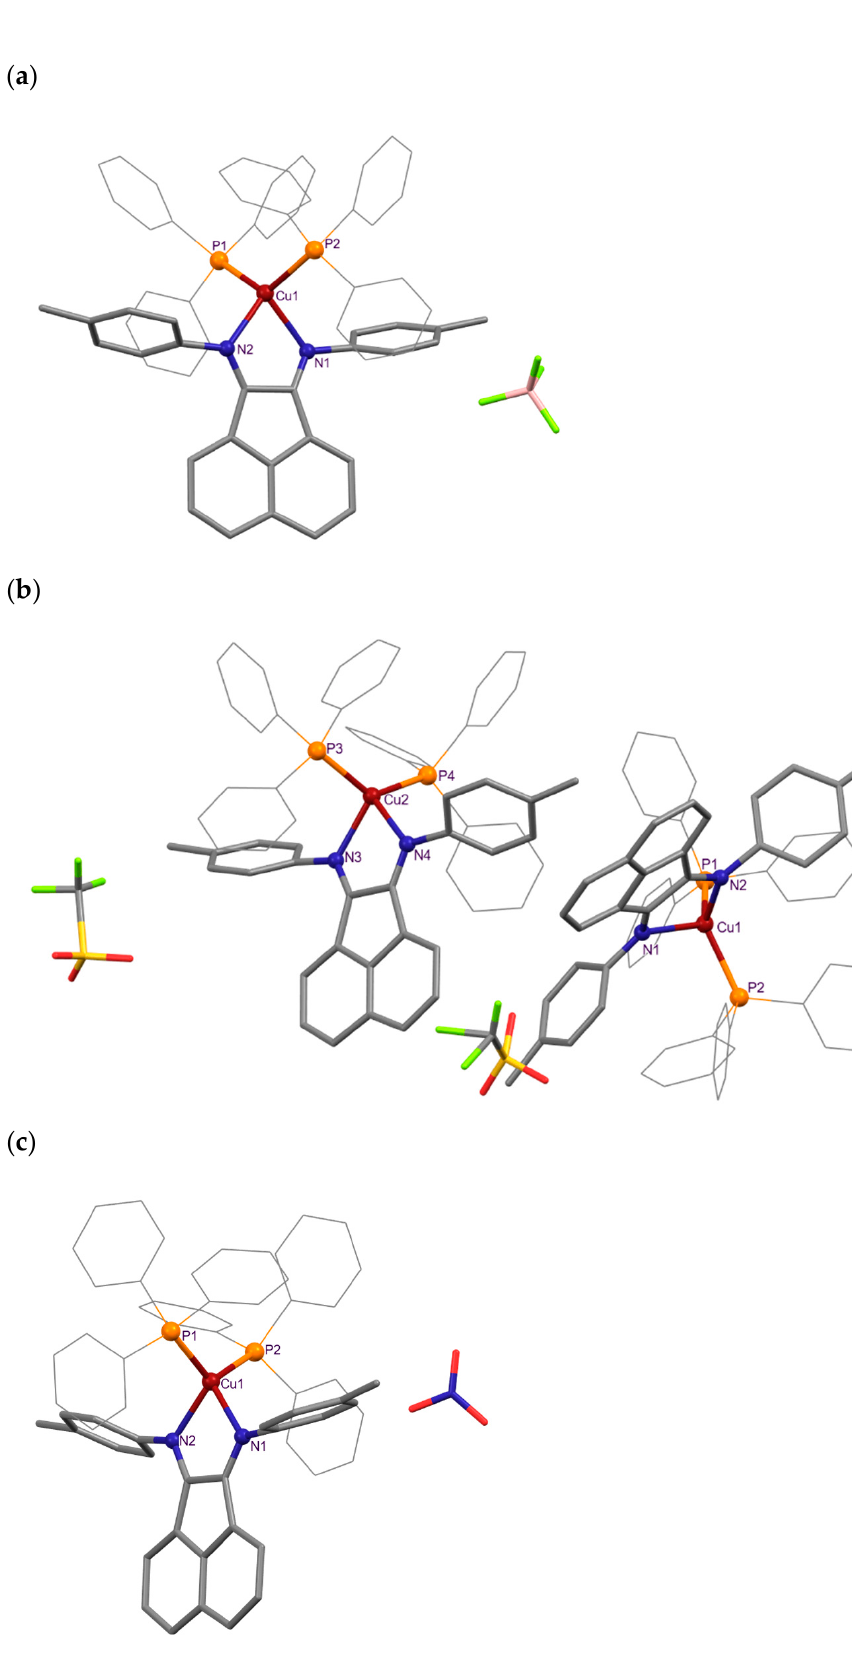
Figure 2. Mercury representations of the asymmetric units of complexes ( a ) 1 BF4 , ( b ) 1 OTf and ( c ) 1 NO3 . All hydrogen atoms and co-crystallized CH 2 Cl 2 (in 1 BF4 ) and CHCl 3 (in 1 OTf ) solvent molecules were omitted for clarity.